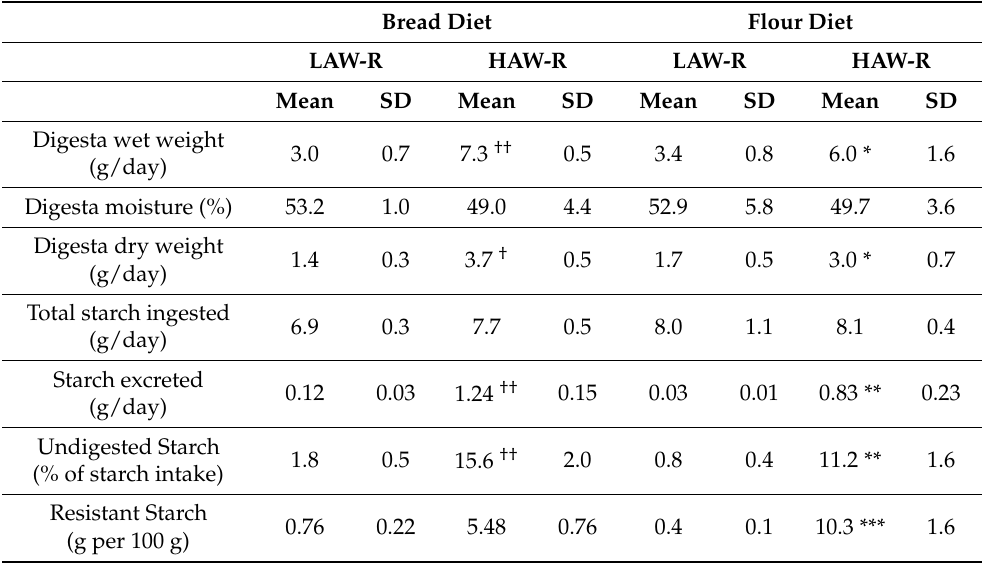
Table 2. The effect of diets containing LAW and HAW bread and flour on starch ingestion and excretion in ileorectomised